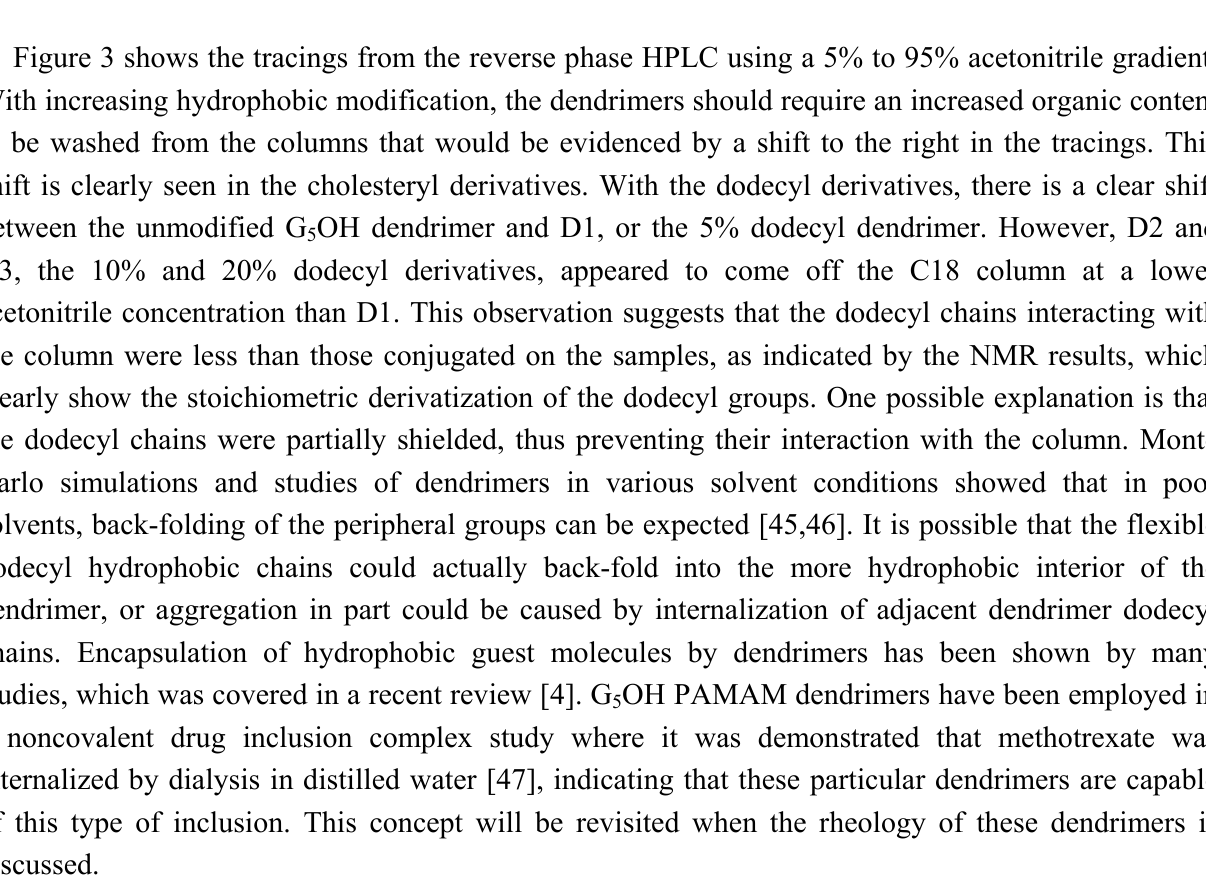
Figure 3. HPLC UV tracings at 230 nm of control and modified dendrimers analyzed on reverse phase C18 columns to show hydrophobicity. (a) G